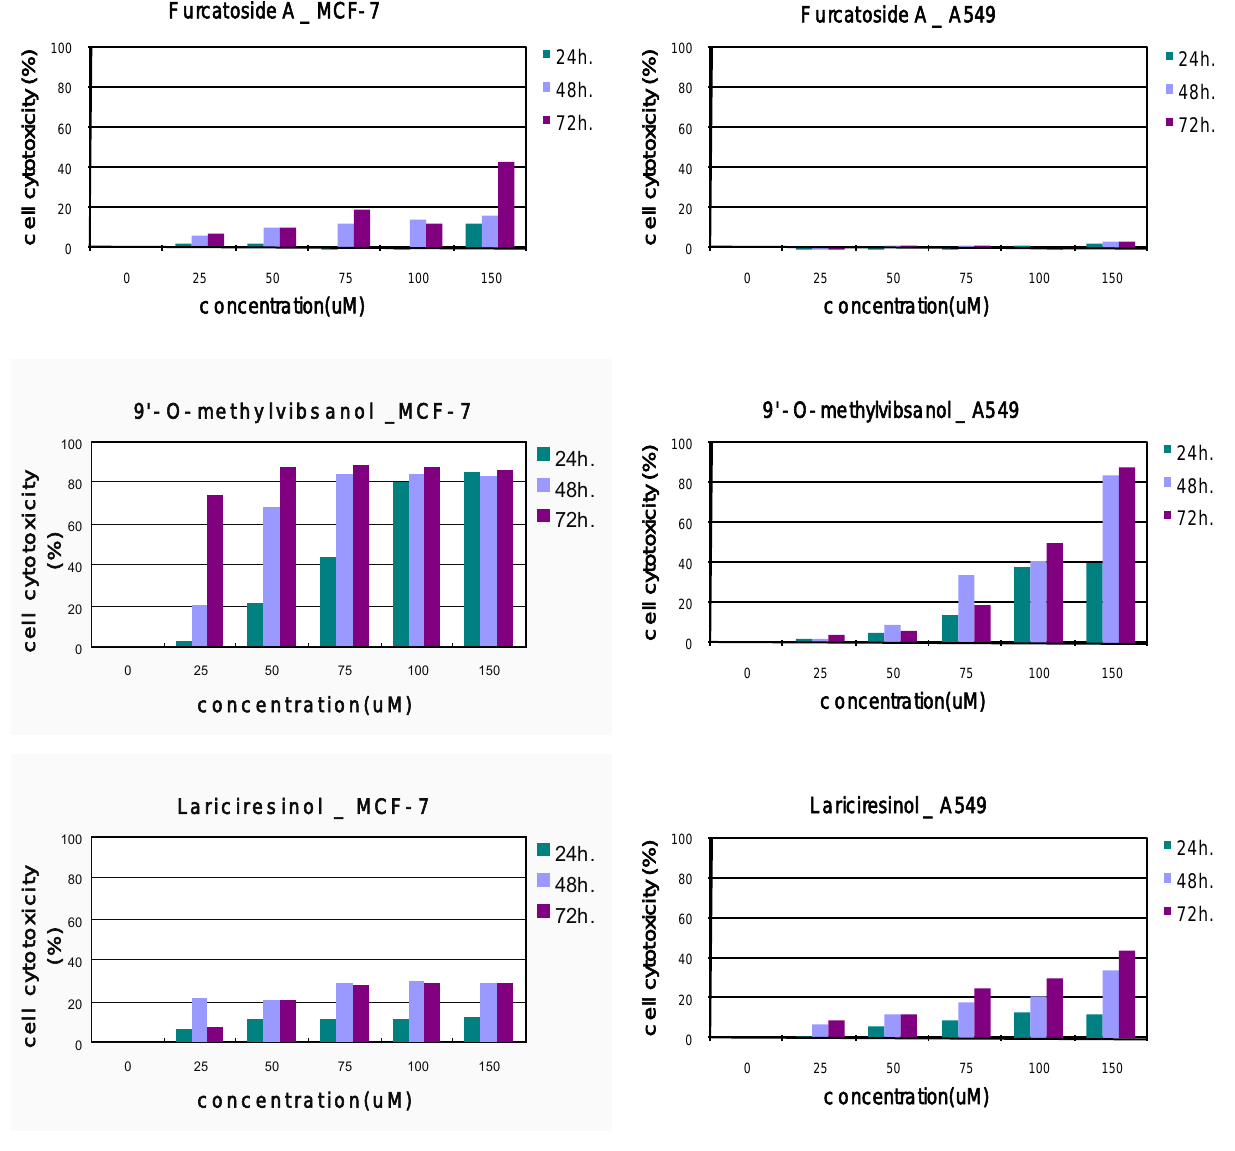
Table 1. Cytotoxic effects of compounds in tumor cell lines. IC